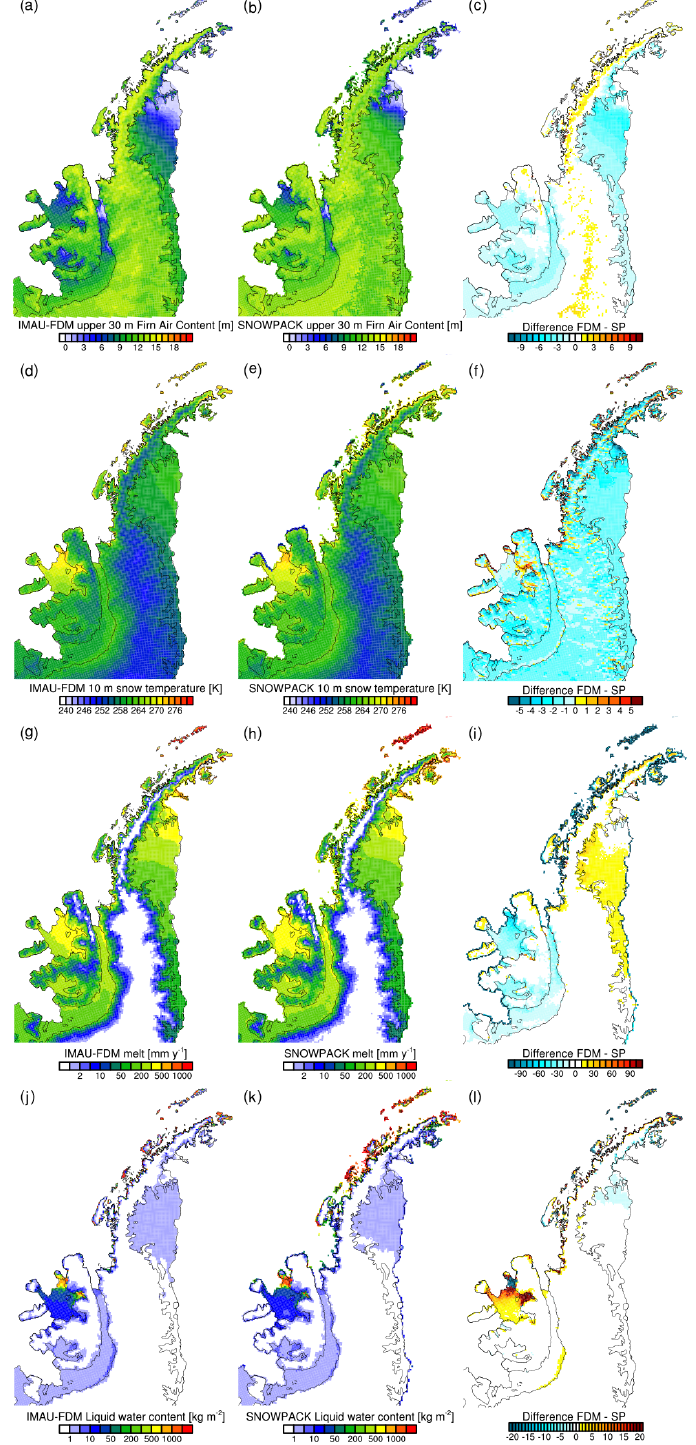
Figure 4. Annual average (1979–2016) of modelled IMAU-FDM (left column), SNOWPACK (middle column), and their difference (IMAU- FDM – SNOWPACK) (right column): (a–c) firn air content (FAC; m), (d–f) 10m snow temperature ( K ) , (g–i) surface meltwater production (mmw . e . yr − 1 ), and (j–l) vertically integrated liquid water content (km 2